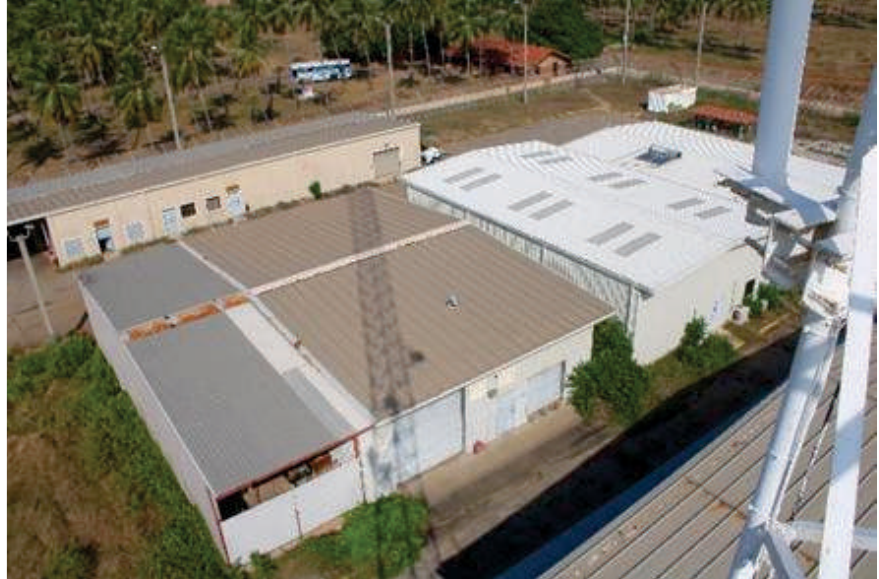
Figure 2: Former VoA Complex Iranawila (aerial view)